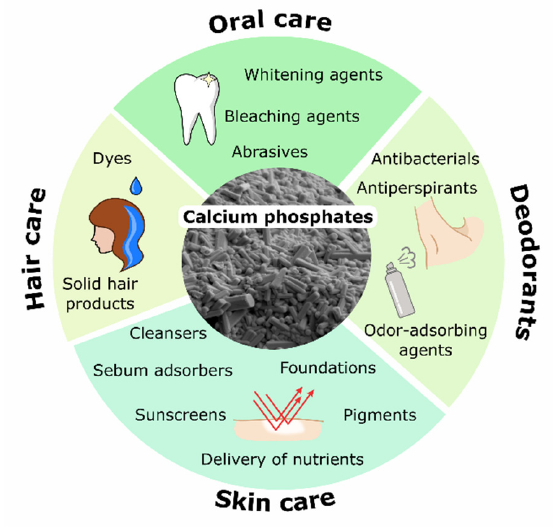
Figure 3. Current and potential application of calcium phosphates in the cosmetics field.